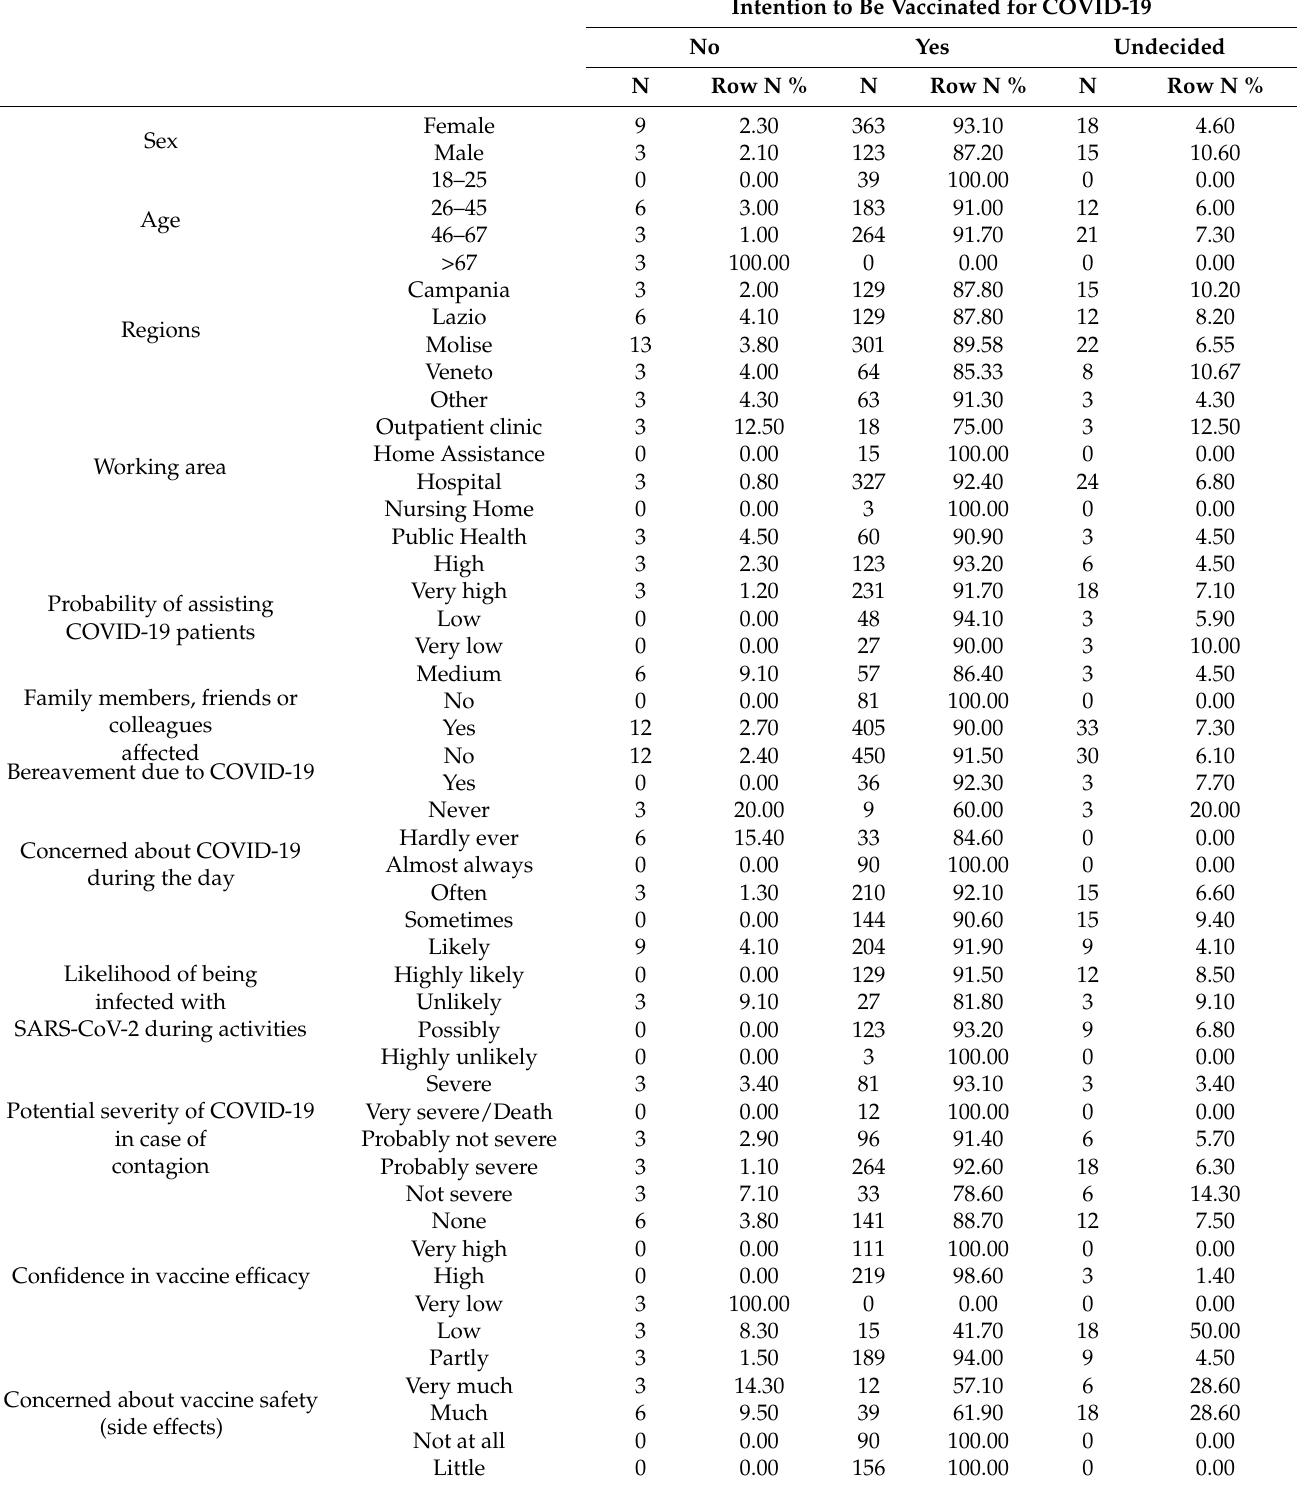
Table 1. Main results of questionnaire by intention to be vaccinated among study